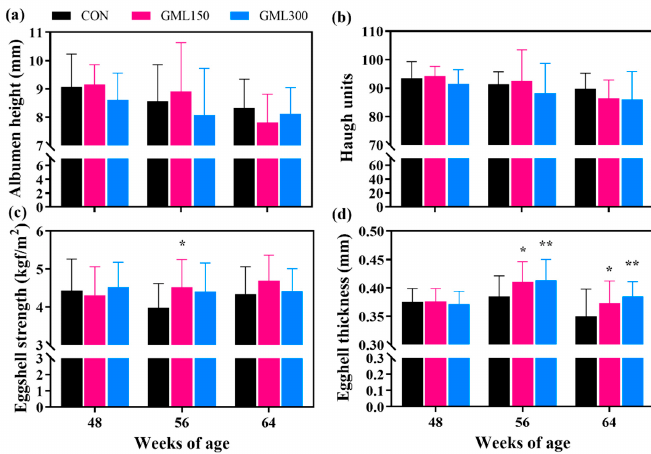
Figure 2. Effect of dietary GML on egg quality of Hy-line brown laying hens. ( a ) Albumen height; ( b ) Haugh units; ( c ) eggshell strength and ( d ) eggshell thickness. All data were expressed as means ± SD ( n = 6). Asterisk indicates significantly differences according to ANOVA (* p < 0.05, ** p < 0.01).